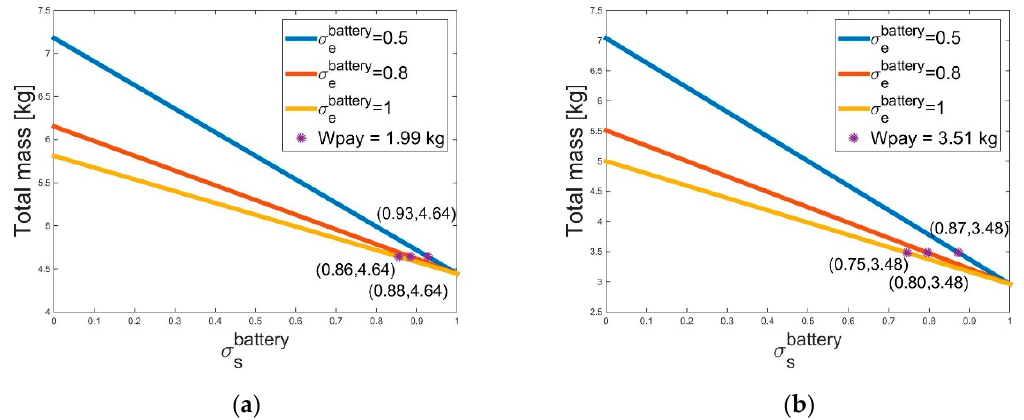
Figure 5. System masses for the various structural efficiencies ( σ s ) and Energy Densities ( σ e ). ( a ) Payload weight ( W pay ) = 1.99 kg; and ( b ) W pay = 3.51 kg.